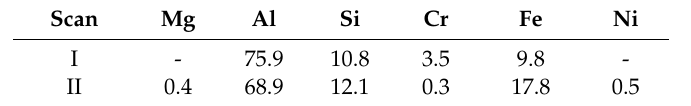
Figure 18. SEM micrographs revealing Si and Ni precipitations in AlSi7Mg0.3 in the vicinity of fishbone-like phases of C_1000: ( a ) image magnified to 100 × ; ( b ) image magnified to 300 × . Table 14. Results of EDS scans corresponding with areas indicated by arrows in Figure 17 (in at %).